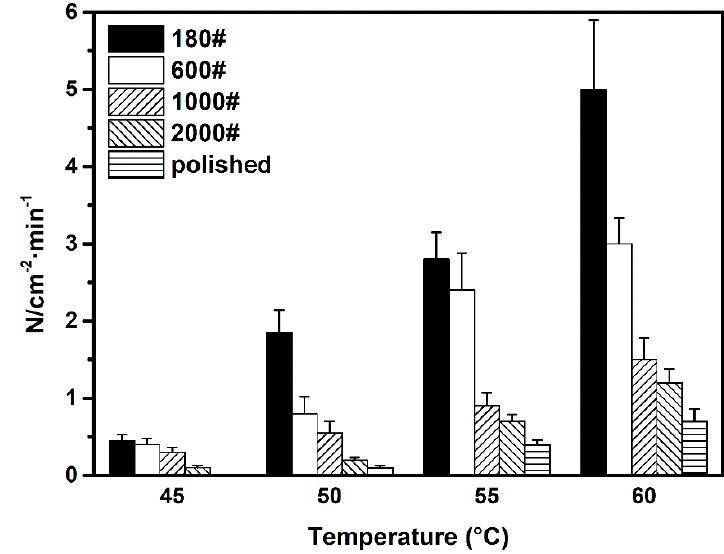
Figure 11. Metastable pitting rate of different surface roughness specimens measured at four testing temperatures.